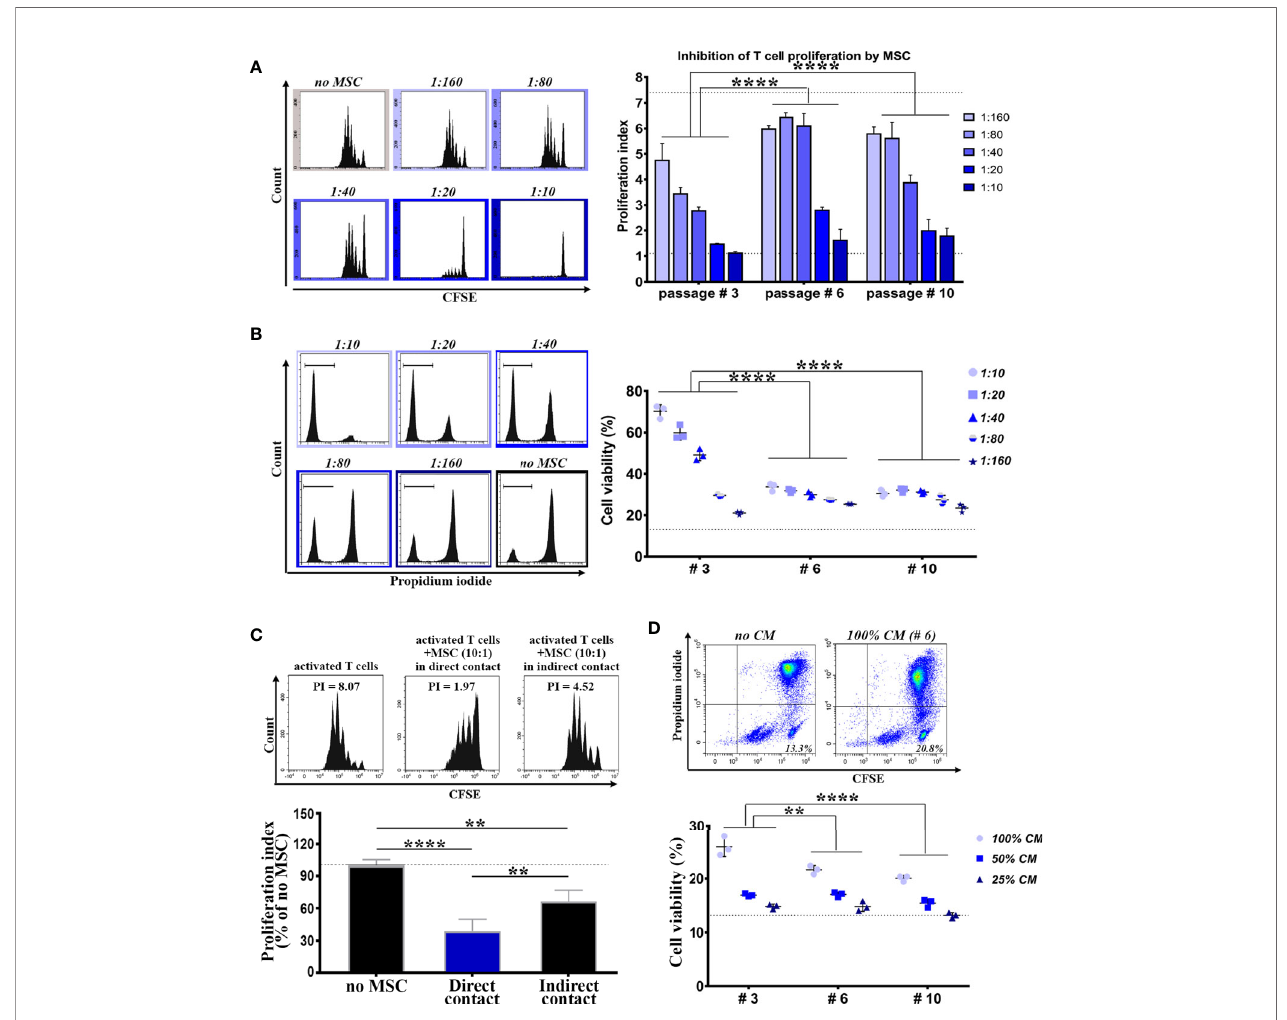
FIGURE 2 | Comparative analysis of the immunomodulatory properties of cells within culture at low, intermediate and high passages. (A) The immunosuppressive effect of cells on splenic T cell proliferation in vitro. T cells were cultured in the presence of activating beads (1:1 ratio) and increasing numbers of irradiated cells, so that to span the interval of MSC: T cell ratio between 1:160 and 1:10 (constant number of T cells). Shown data represent mean +/- SD of one representative experiment performed in triplicates. At least three experiments were performed with similar results. (B) The pro-survival effect of cells on the viability of resting T cells in vitro . T cells were cultured in resting conditions in the presence of increasing numbers of irradiated cells. Shown data represent mean +/- SD of one representative experiment performed in triplicates. At least three experiments were performed with similar conclusions. (C) The suppressive effect of MSC (passage #6) on T cell proliferation in vitro , in the absence of cell-cell contact between MSC and T cells. (D) The pro-survival effect of the conditioned medium (CM) produced by cells on resting T cells in vitro . Shown data represent mean +/- SD of one representative experiment performed in triplicates. At least six experiments were performed with same conclusion. **p < 0.01, ****p <